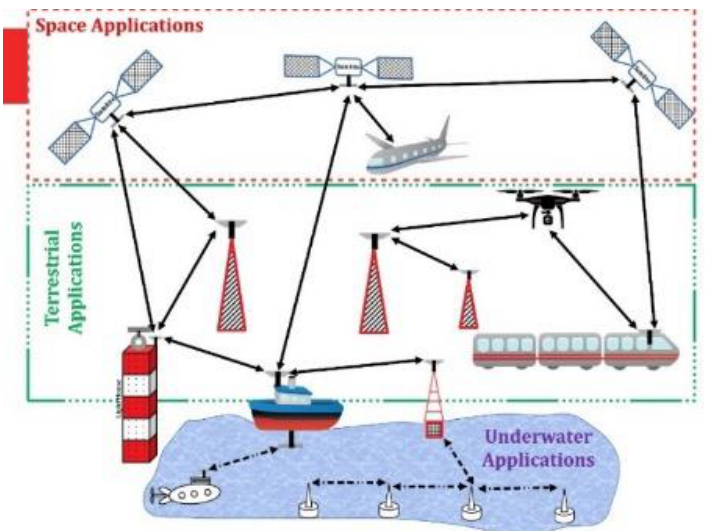
Figure 30. Communication network architecture for underwater, air, and space connectivity.